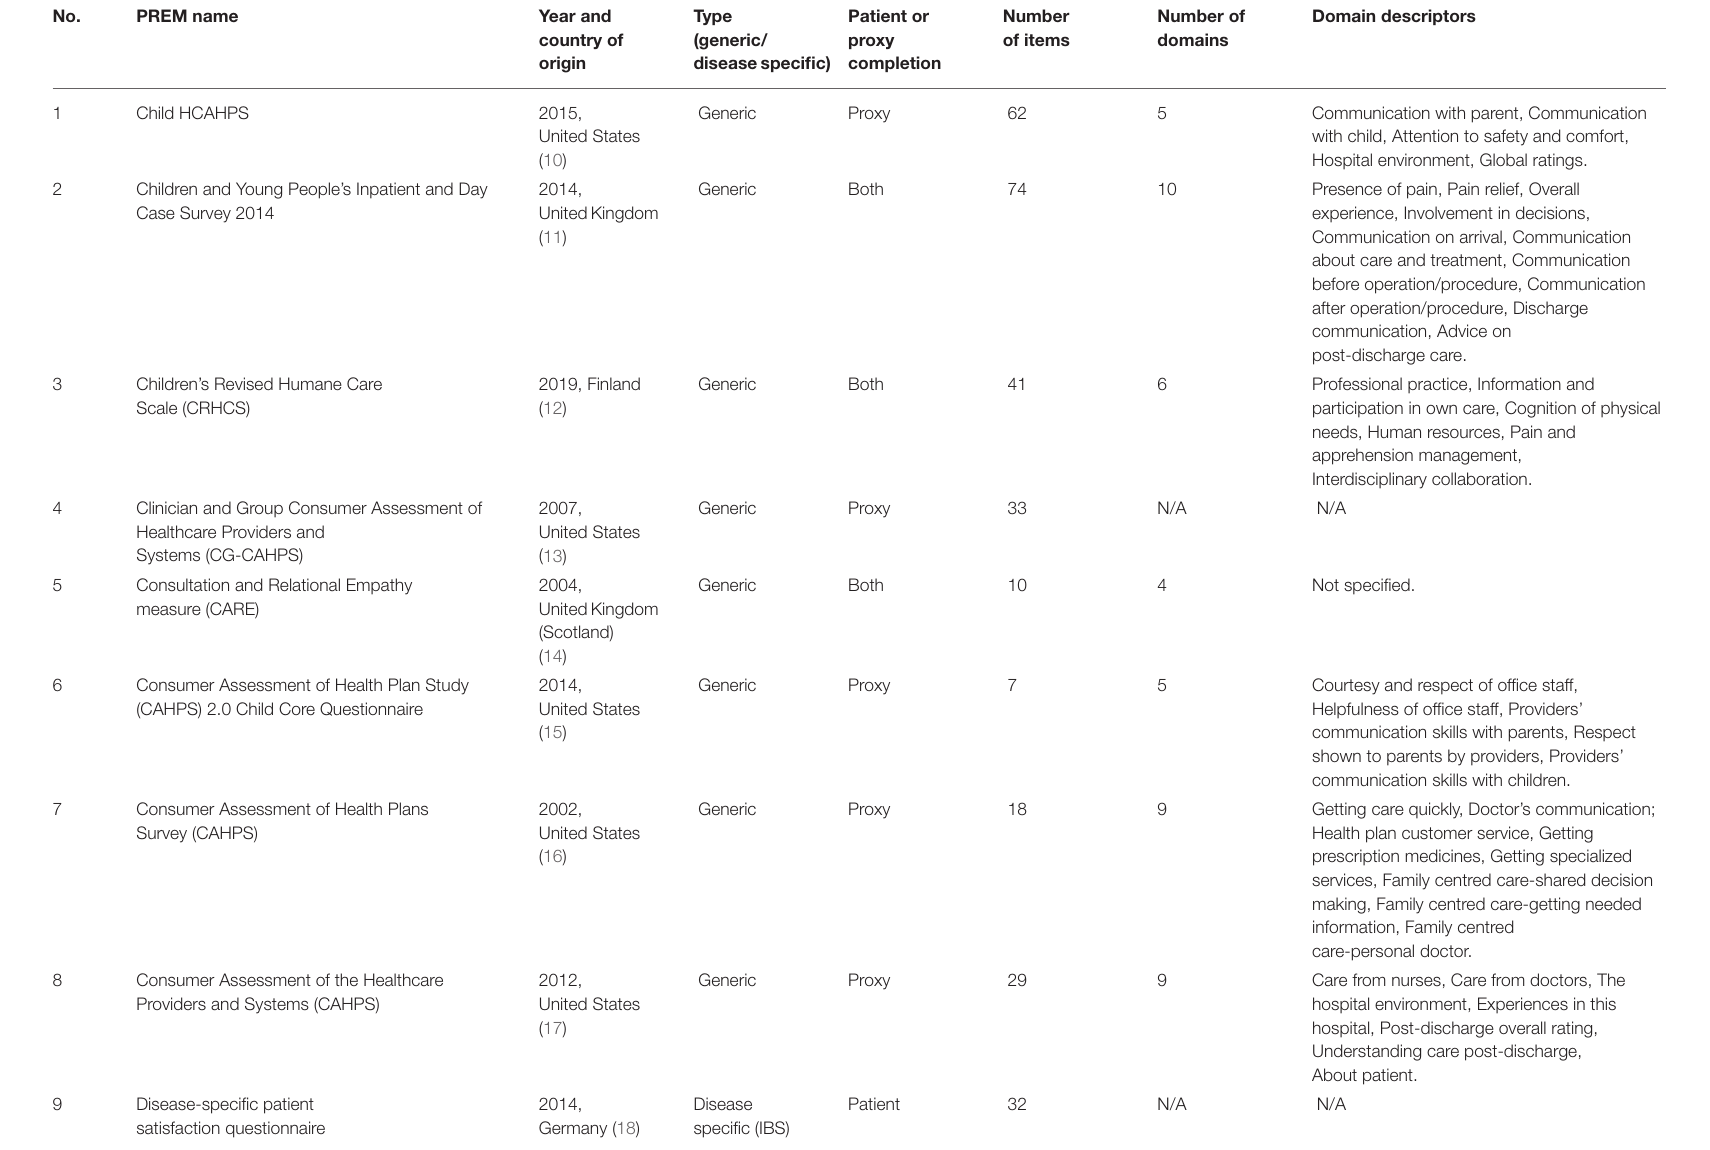
TABLE 1 | Summary of the pediatric patient-reported experience measures.